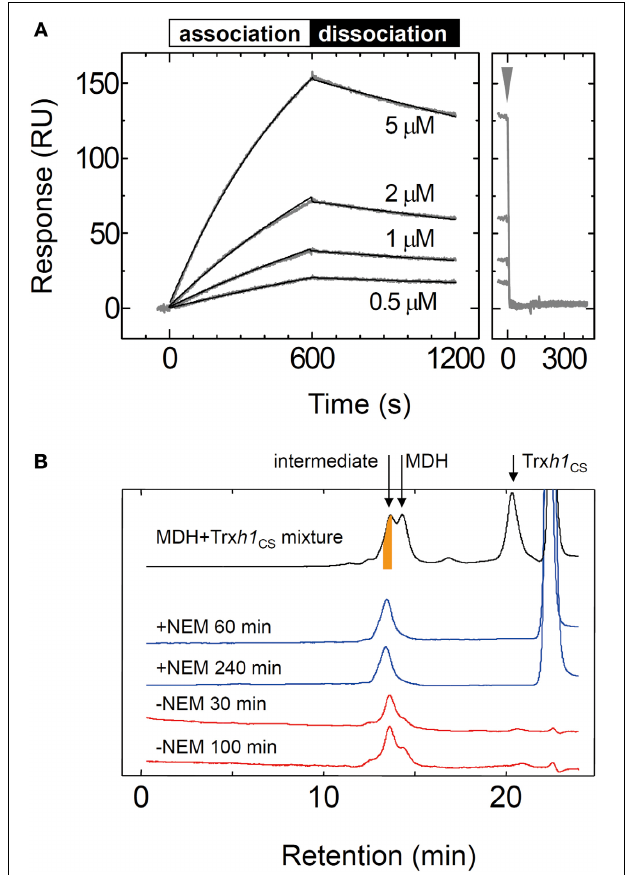
FIGURE 2 | Interaction between the oxidized form of the MDH and Trx h 1 CS proteins. (A) To investigate the association and dissociation phases, the indicated concentrations of MDH were injected for 600s, followed by injection by buffer for additional 600s (left panel) and the SPR signals were recorded. Fitted curves are indicated by the black lines on the SPR sensorgram. The association and dissociation phases are indicated by bars on the sensorgram. The arrow indicates the time when 5mM DTT was injected (right panel). (B) Mixed disulfide intermediate complexes formed by the Trx h 1 CS and oxidized MDH were separated by gel filtration chromatography (TSK-G2000SW XL ) (black trace). The intermediate complexes (orange colored portion) were fractionated and then applied to the same column chromatography after incubation for the indicated period in the presence (blue trace) or the absence (red trace) of 10mM